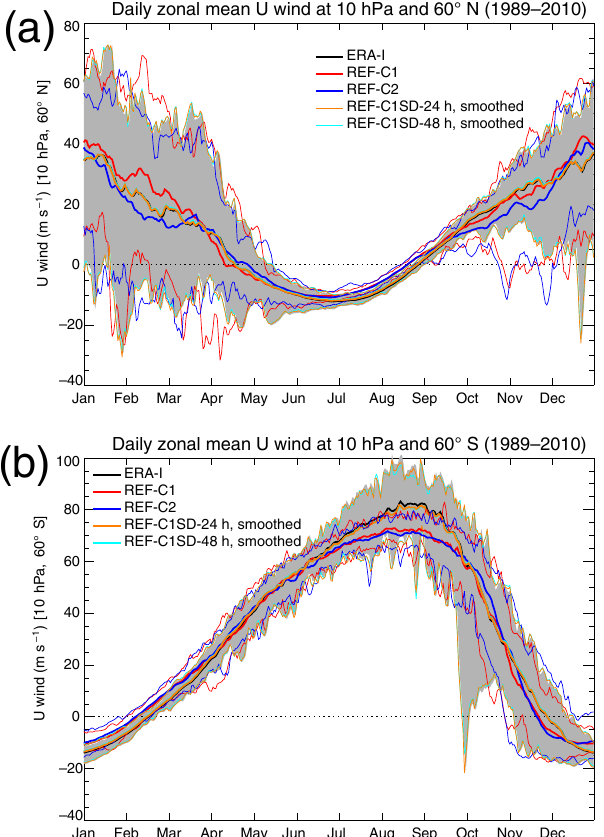
Figure 4. Polar vortex variability for the (a) Northern Hemisphere and (b) Southern Hemisphere. Thick solid lines show mean values, and maximum and minimum values are shown by thin solid lines for the model simulations and shading for ERA-I over the years 1989–2010. Tick marks indicate the middle of each